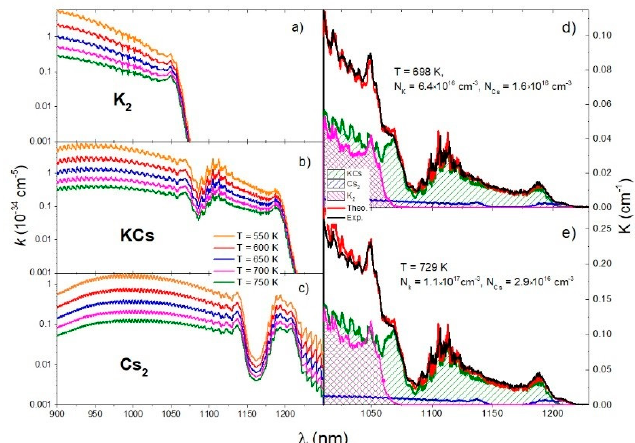
Figure 7. The first column shows the reduced absorption coefficients of K 2 , KCs, and Cs 2 molecules ( a – c , respectively) in the temperature range T = 550 K–750 K. The comparison of the experimental absorption coefficient (black curve) with the theoretical simulation (red curve) is in the second column ( d , e ). The theoretical simulations of the contributions of KCs, Cs 2 , and K 2 molecules are shown in green, blue, and magenta, respectively.